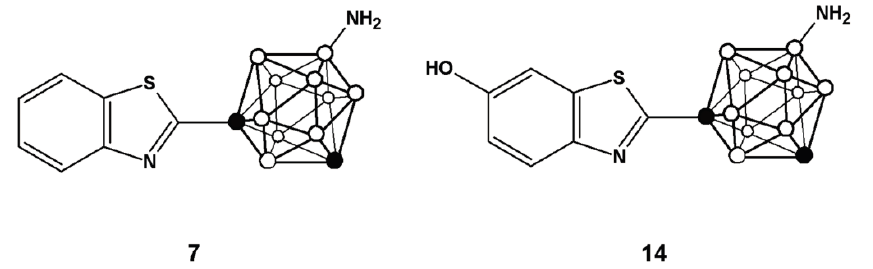
Figure 2. Chemical structure of the two analogues incorporating m -carborane developed in the current